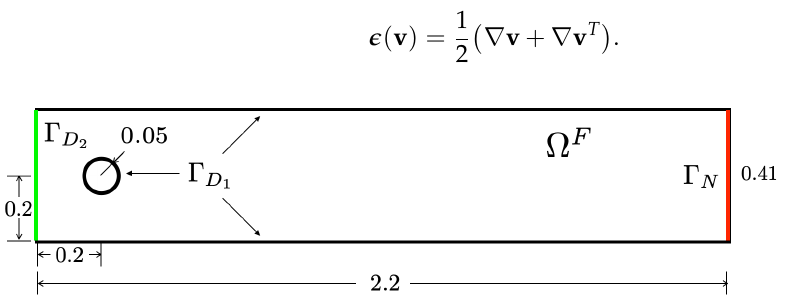
Figure 2. Test case 1 : geometrical configuration, domain and boundaries